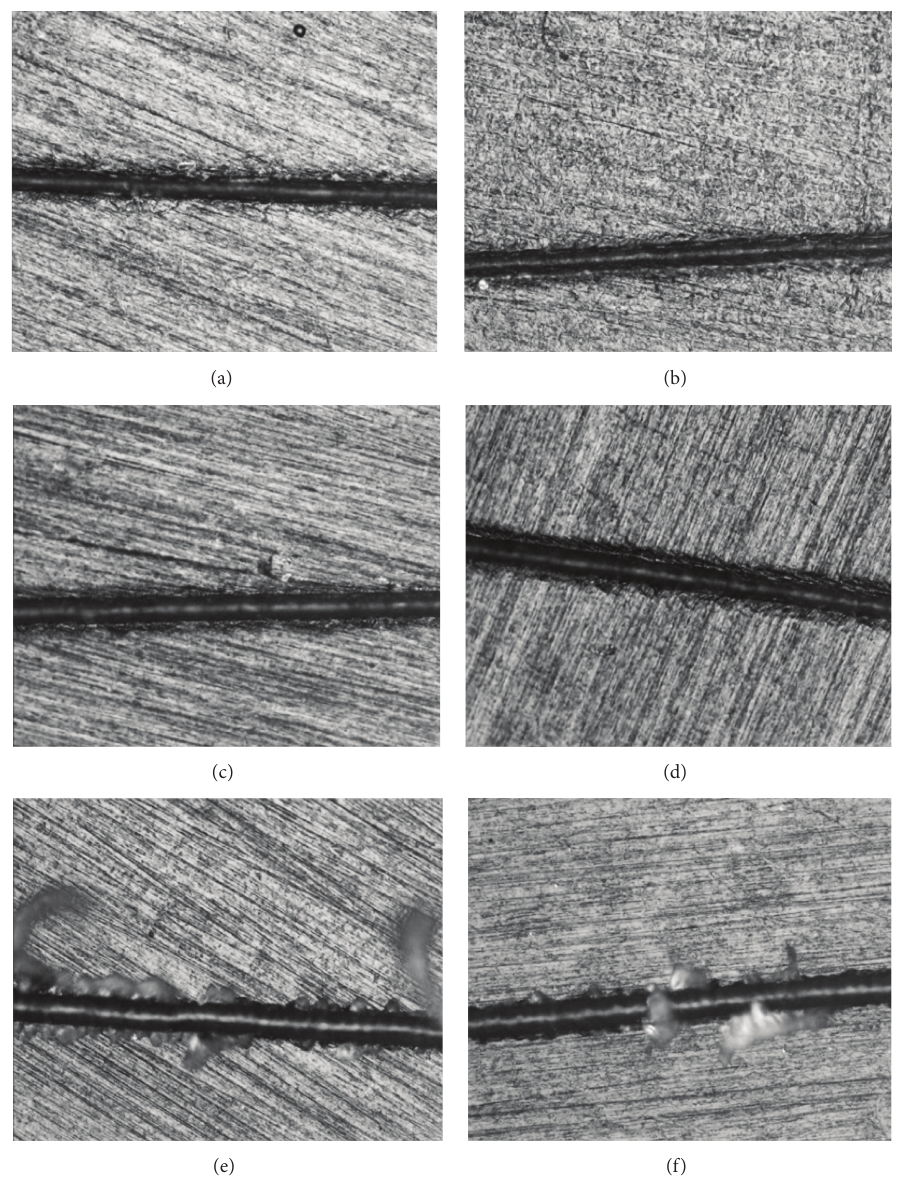
Figure 6: Optical scratching images of test samples ( × 20): (a) UHMWPE; (b) GO/UHMWPE nanocomposites; (c) irradiated UHMWPE; (d) irradiated GO/UHMWPE nanocomposites; (e) irradiated + aged UHMWPE; (f) irradiated + aged GO/UHMWPE